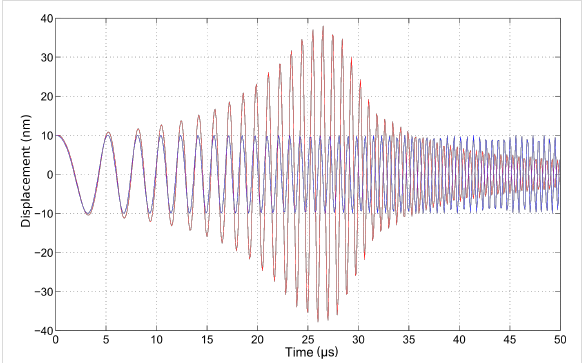
Figure 1: The response of a damped harmonic oscillator (red line) to a chirped driver (blue line) whose frequency is linearly swept in the interval 0.1 f 0 < Δ f < 0.9 f 0 over 50 μ s, where f 0 = ω 0 /(2 π ) = 1 MHz is the resonant frequency of the oscillator. The quality factor is Q = 4 and the initial conditions are 10 nm amplitude and zero